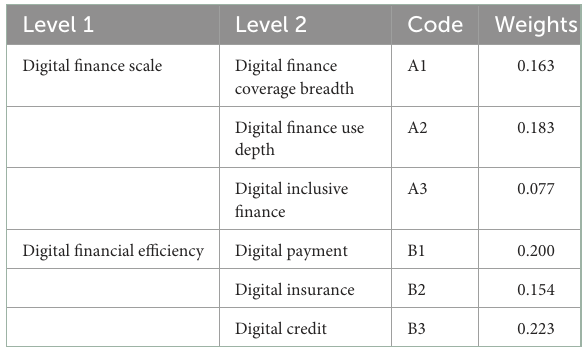
TABLE 1 Index system of digital financial